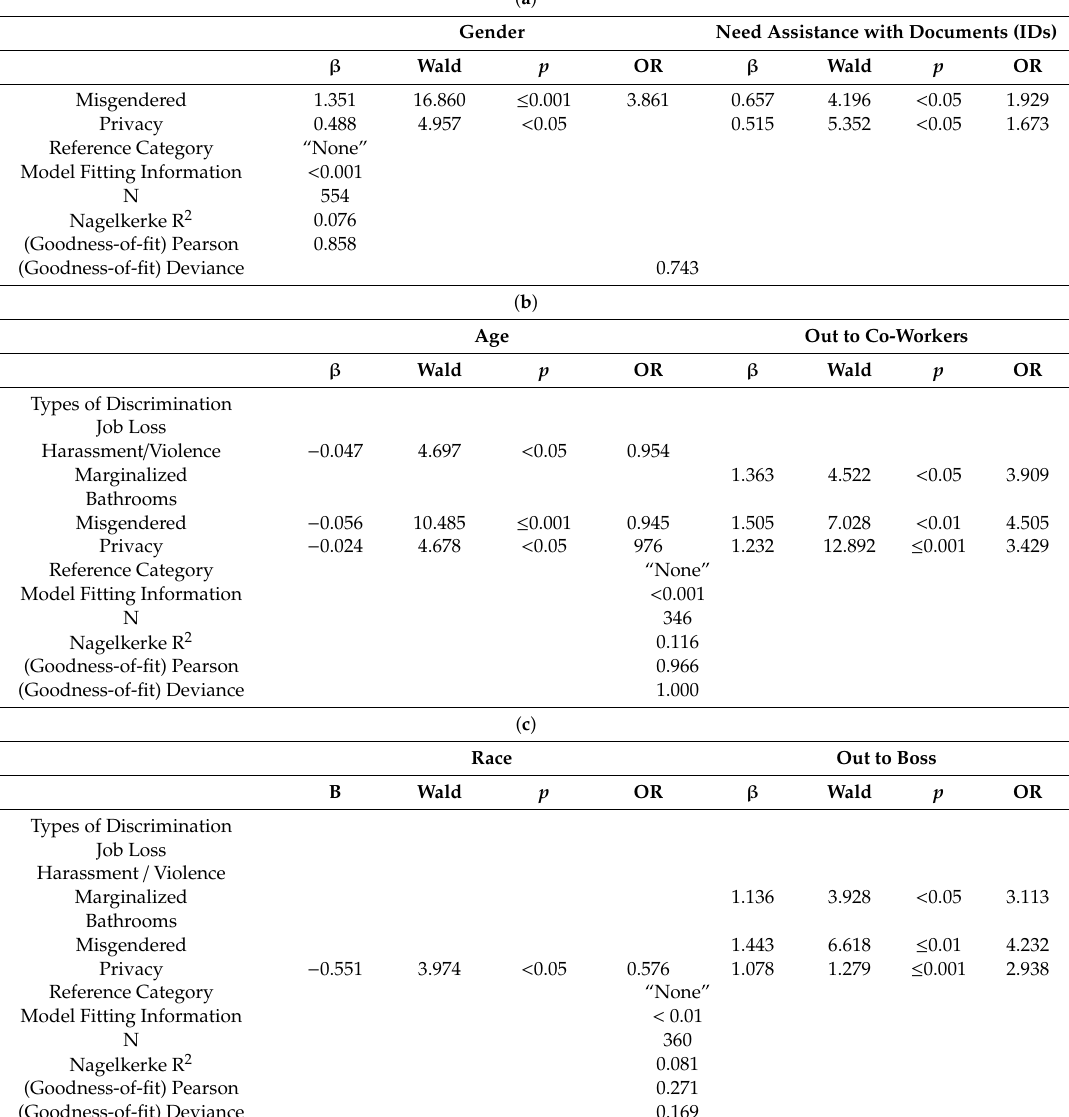
Table 5. ( a ) Gender and IDs by Types of Discrimination. ( b ) Age and Out to co-workers by Types of Discrimination; ( c ) Race and Out to Boss by Types of